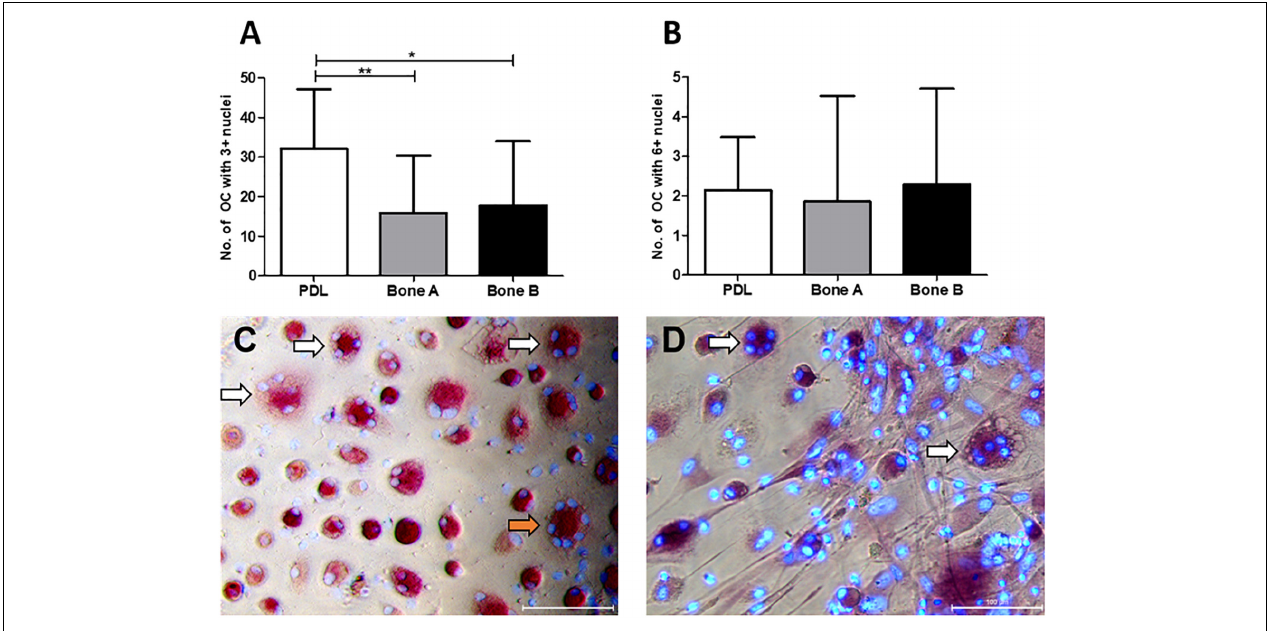
FIGURE 8 | Osteoclasts at day 21. Cells from PDL, bone A and bone B were co-cultured with PBMCs as a source of osteoclast precursors. Quantification of osteoclasts was performed after staining for TRAcP activity and after staining nuclei with DAPI. Cells with at least 3 nuclei per 5 standardized fields per well were quantified. (A) Number of osteoclasts with ≥ 3 nulcei. PDL induced a significantly higher number of osteoclasts compared to bone A and B. (B) Number of osteoclasts with ≥ 6 nuclei without significant differences between the 3 cell cultures. Note the difference in scale of the y-axes between the graphs. Bars represent means ± SD. * p < 0.05; ** p < 0.01 (One-way ANOVA (repeated measures) with a Tukey’s multiple comparison post hoc test). Microscopic images of osteoclasts with 3–5 nuclei (white arrows) and 7 nuclei (orange arrow) induced by (C) PDL and (D) bone A. Panel (D) also shows fibroblastic appearances of cells. Bar = 100 µ